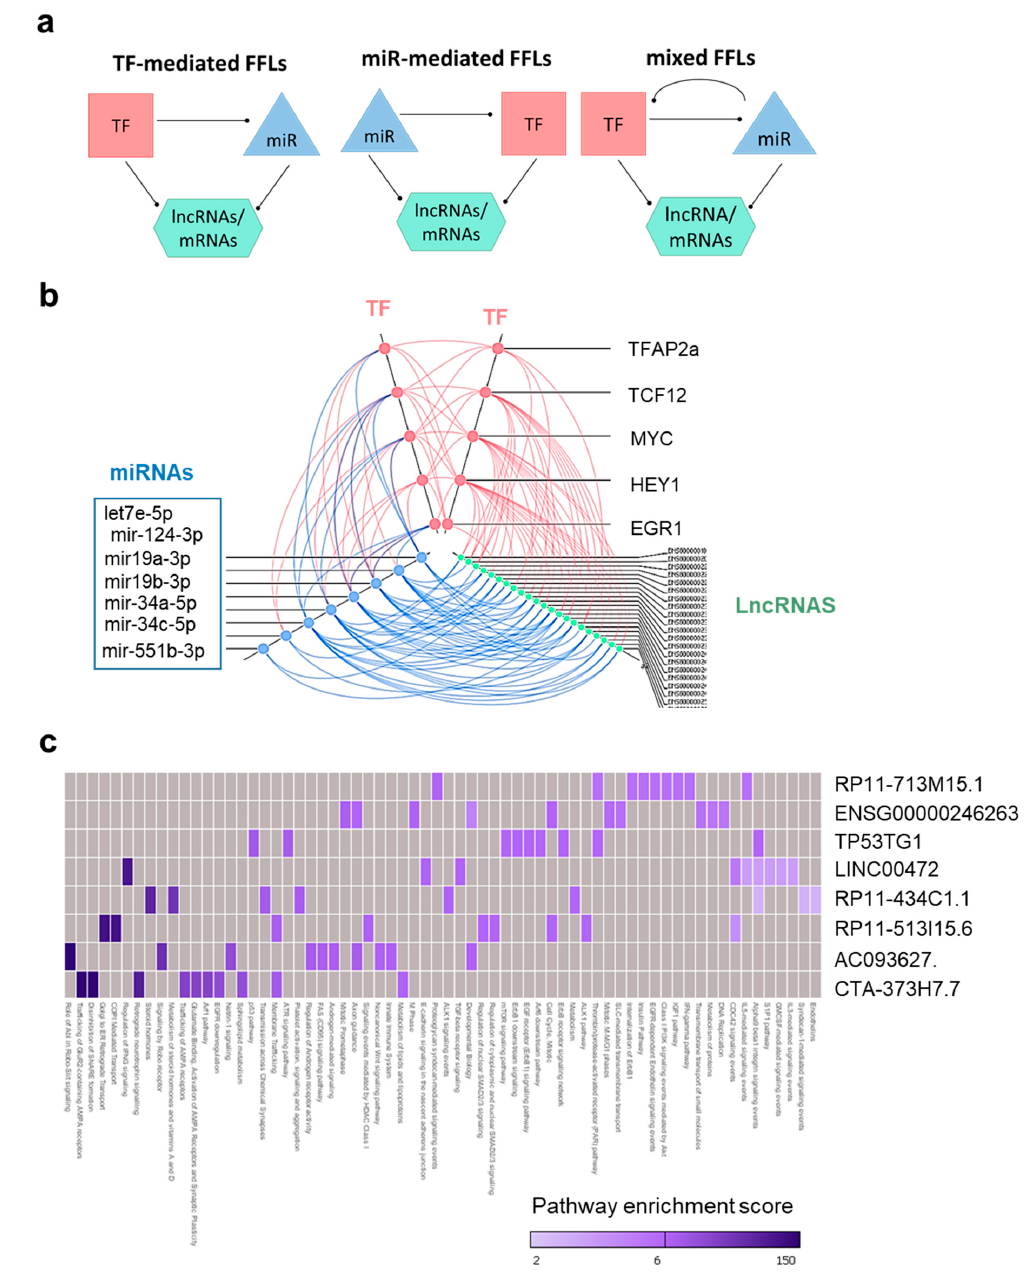
Figure 5. Identification of TMZ-associated transcriptional regulatory motifs involving lncRNAs. ( a ) Graphical representation of the motif structures where mRNAs or lncRNAs are the targets regulated by miRNA (miR) and TF associations. ( b ) Hive plot representing TMZ-regulated FFLs containing lncRNAs from NCH601. Axes indicate different RNA families, with each dot corresponding to a gene (TF, miRNA, or lncRNA) involved in lncRNA-containing loops. Molecular interactions are represented by a color code line (stimulatory interactions in red, inhibitory interactions in blue). ( c ) Heatmap showing enriched pathway for the indicated lncRNAs.